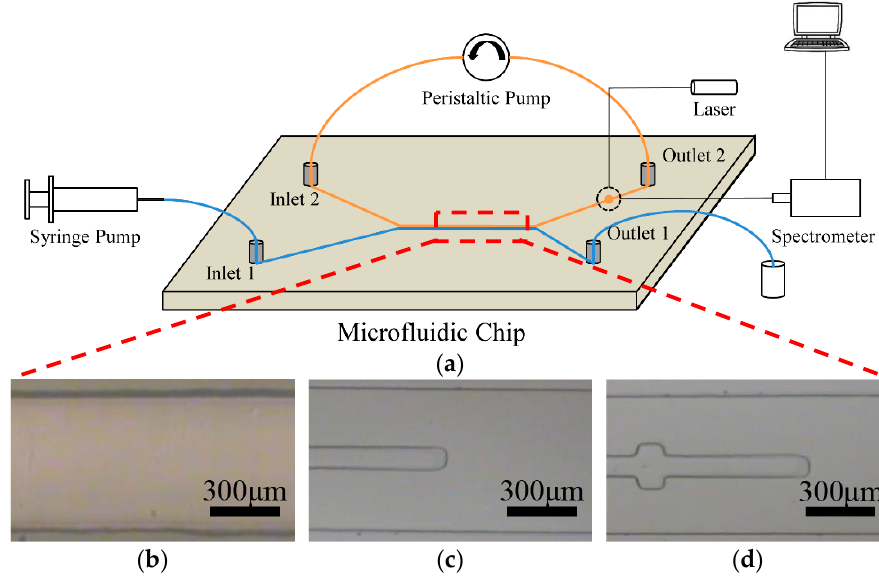
Figure 2. ( a ) An operation schematic diagram of the real-time fluorescence microfluidic chip (blue lines: aqueous phase; orange lines: organic phase), ( b – d ) the microphotograph of auxiliary microstructures lay in the center line of microchannels: the blank channel, the rectangle shape, the cross shape respectively.